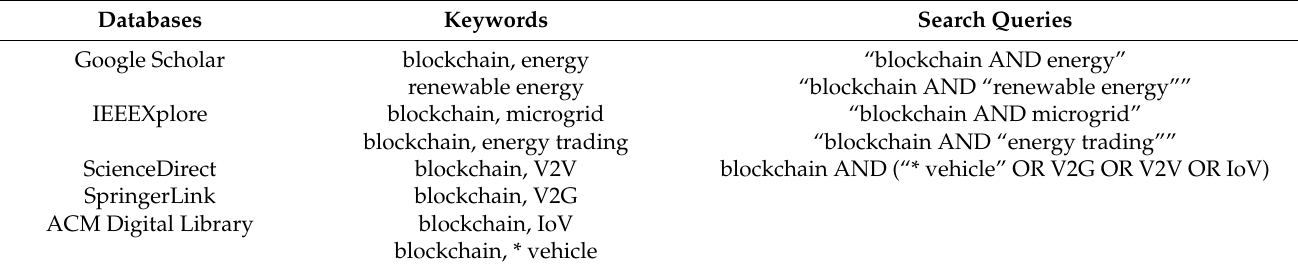
Table 1. Selected databases, keywords and